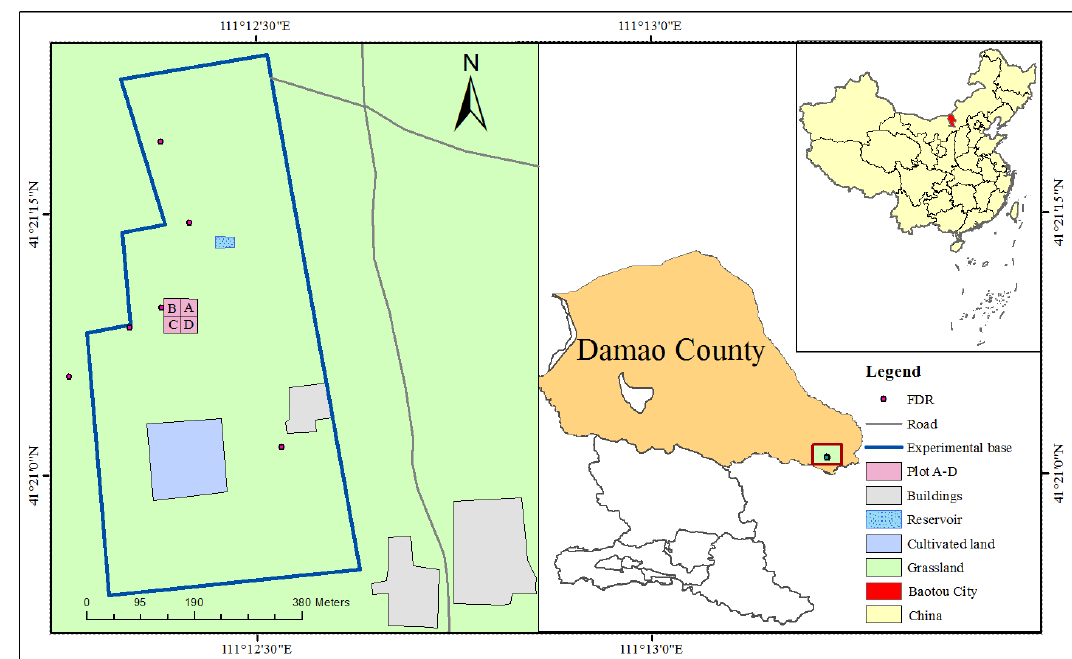
Figure 1. The location of the study